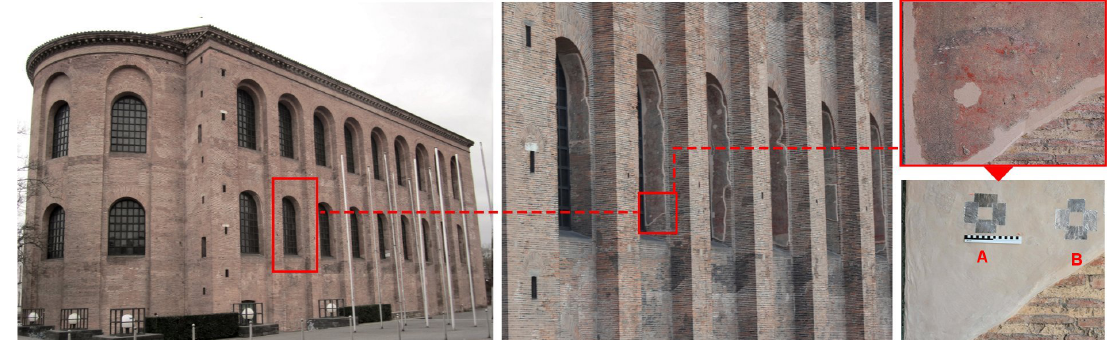
Figure 6. Photographs from the Konstantinbasilika identifying the area where the conservation intervention was performed. The right-hand-side bottom panel shows the area after conservation with the aluminium foil references around the positions